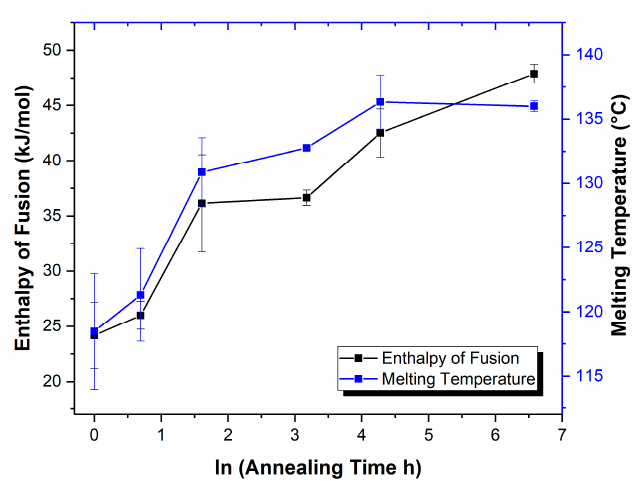
Figure 6. Elevation of melting enthalpy throughout annealing of the VRC-TAR system (T anneal = 60 °C, n = 3).